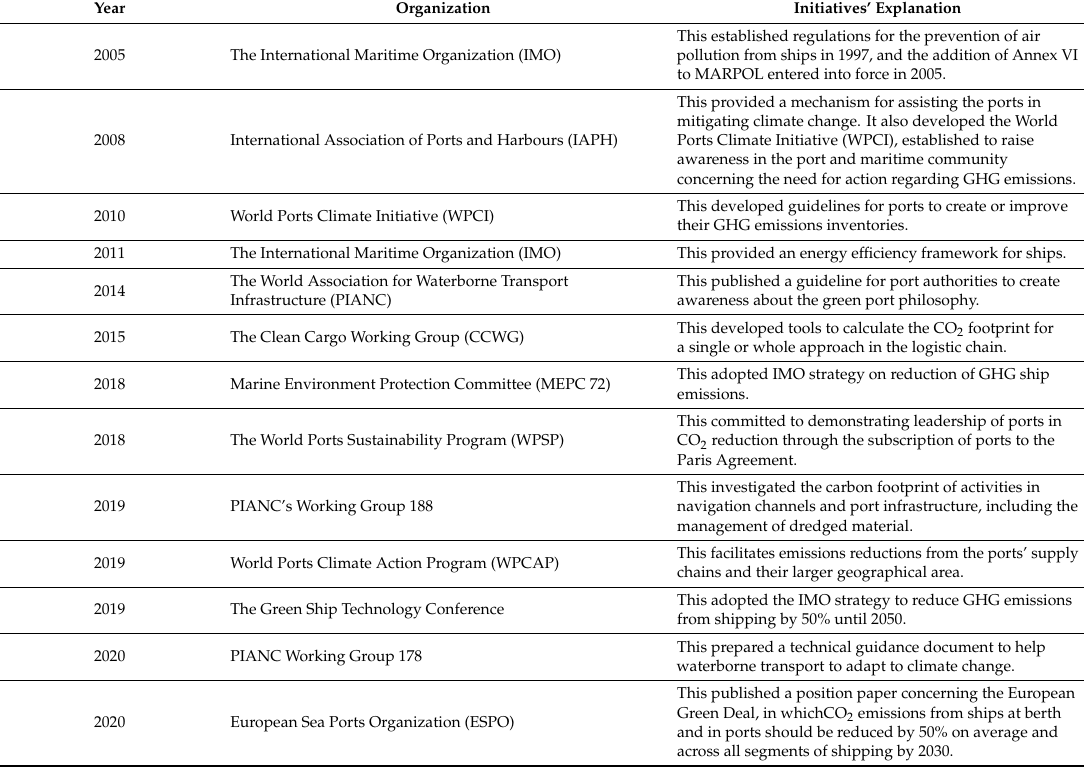
Table 2. Summary of international initiatives to control climate change and carbon footprint in the maritime